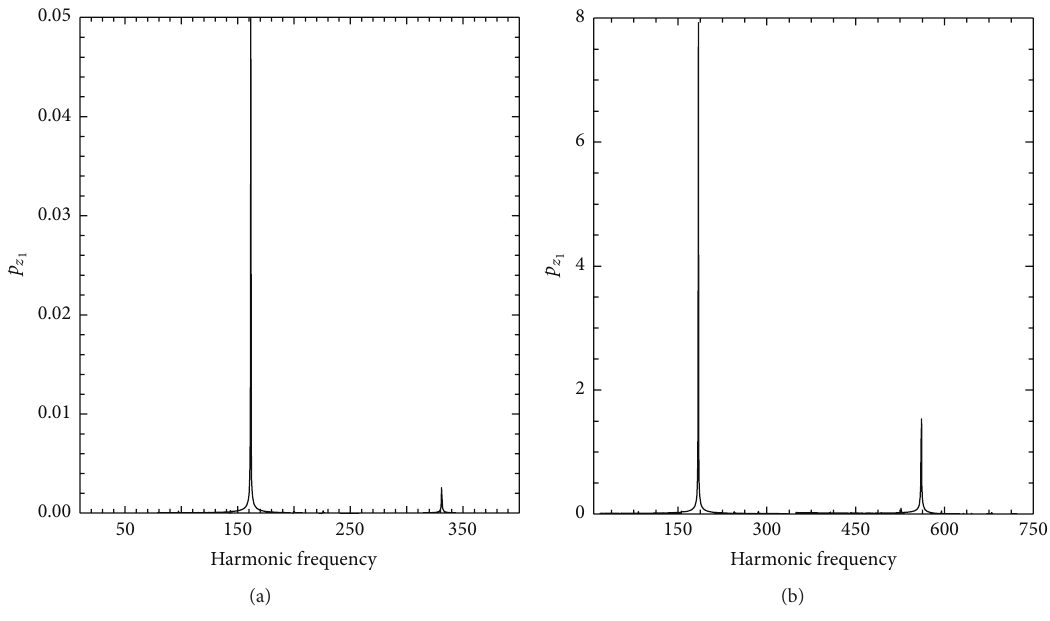
Figure 9: The frequency spectrum for (a) 𝜏 = 3.05 and (b) 𝜏 = 3.46